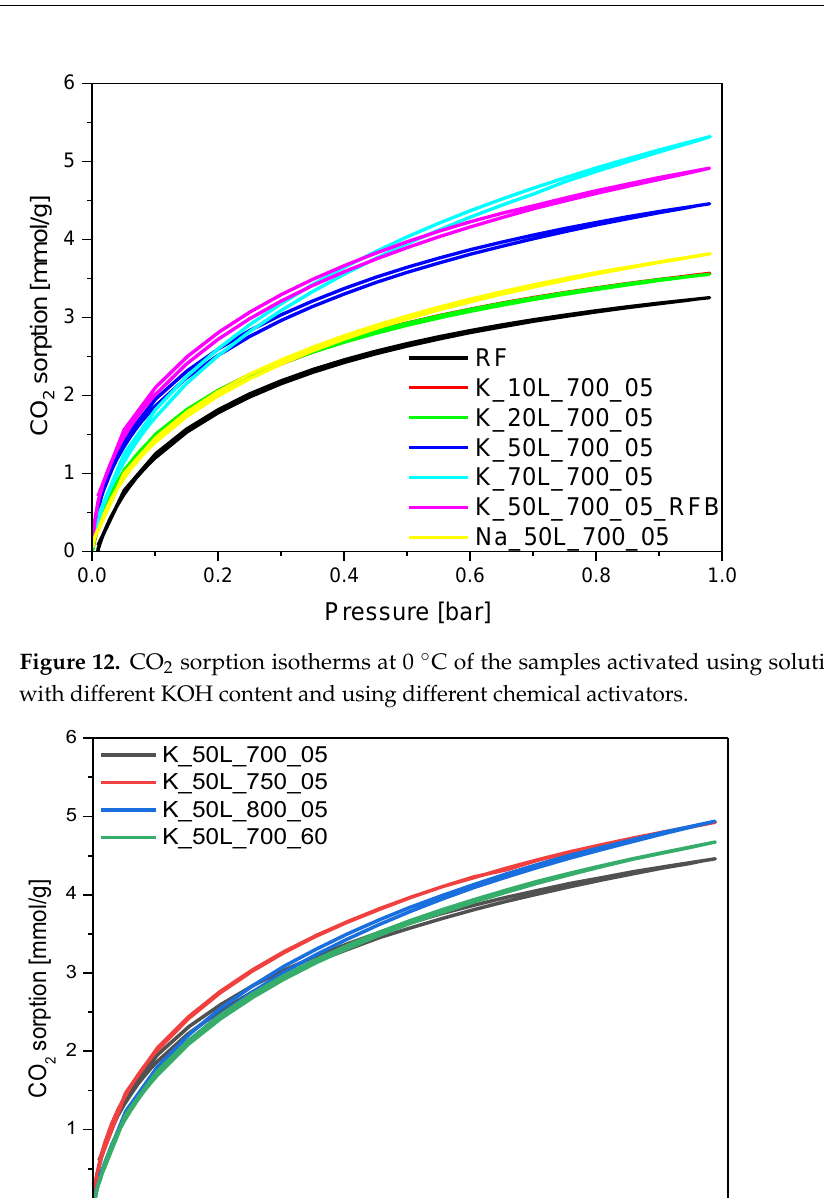
Figure 11. CO 2 sorption isotherms at 0 ° C of the samples activated using solid-based method with different KOH content.